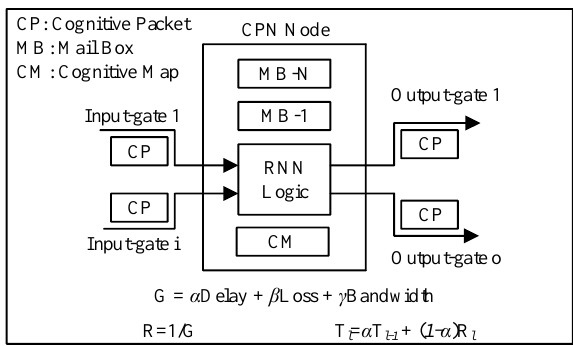
Figure 2. The Cognitive Packet Network (CPN).